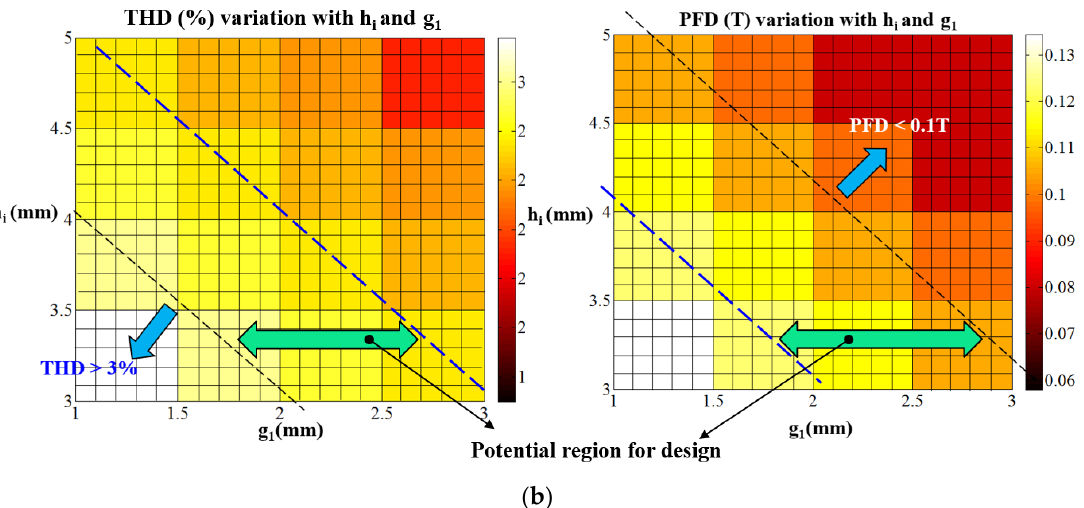
Figure 8. ( a ) variation of PFD and THD with g 1 and h i variation ( b ) design compromise between g 1 and h i for PFD and THD.